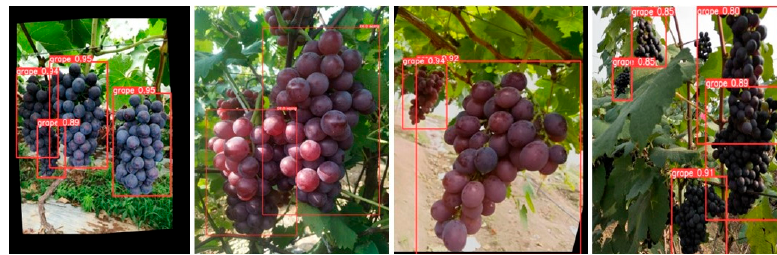
Figure 7. Grape cluster detection results based on YOLOv5s algorithm.